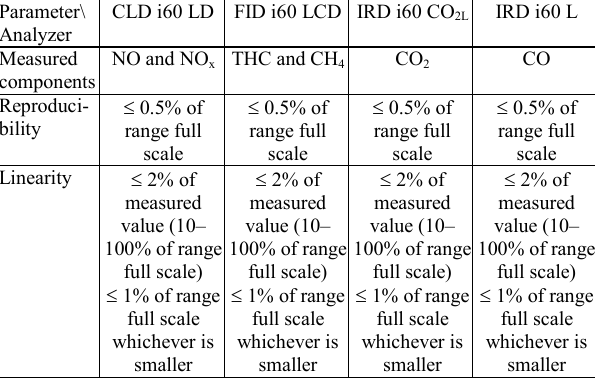
Table 4. Specification of accuracy of AMA i60 analyzers